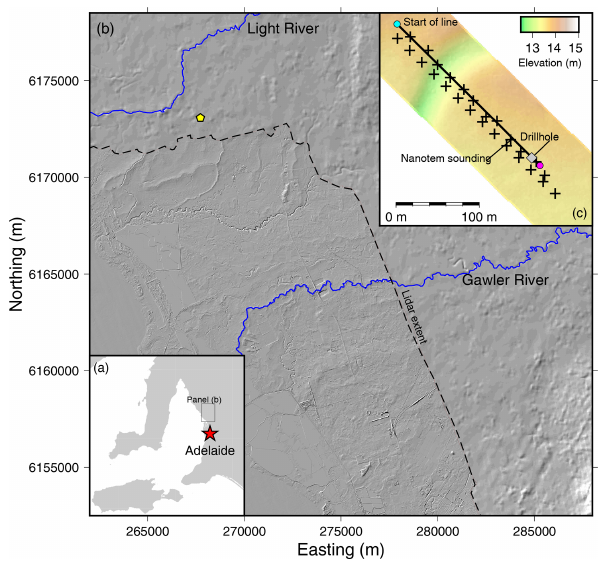
Figure 1. (a) Inset map showing the general location of the study area relative to the city of Adelaide, South Australia. (b) Hill-shaded topographic relief with the lidar data overlaid. The northern extent of high-resolution lidar DEM data is marked with a dashed line. The yellow star represents the site location. The Light and Gawler Rivers are shown in blue. (c) High-resolution topography (drone based) of the field area where the geophysical testing took place. The thick black line is the seismic line, where the cyan dot is the start and the magenta dot is the end. Black crosses represent the location of NanoTEM soundings. The grey square is the shallow drill hole location and also where the downhole NMR data were